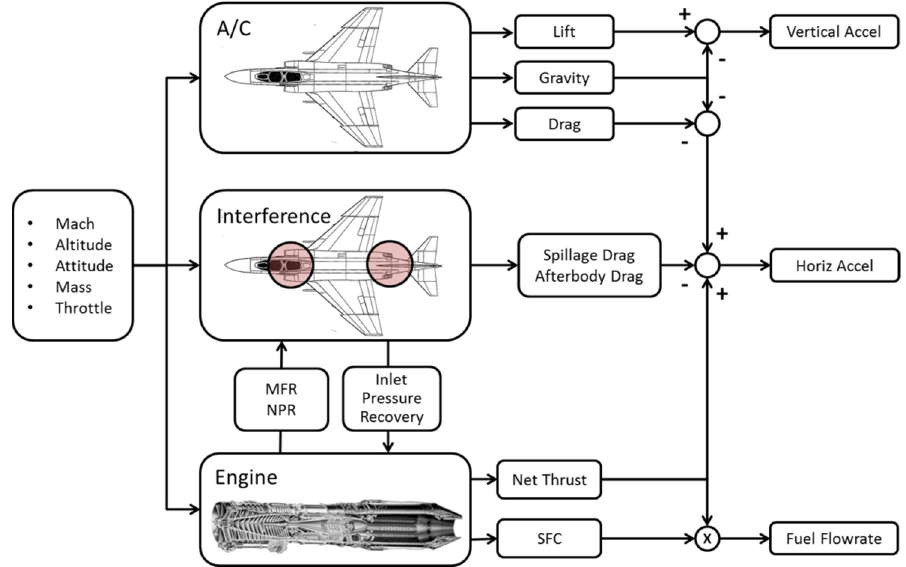
Figure 1. Schematic representation of the aircraft–engine model structure.